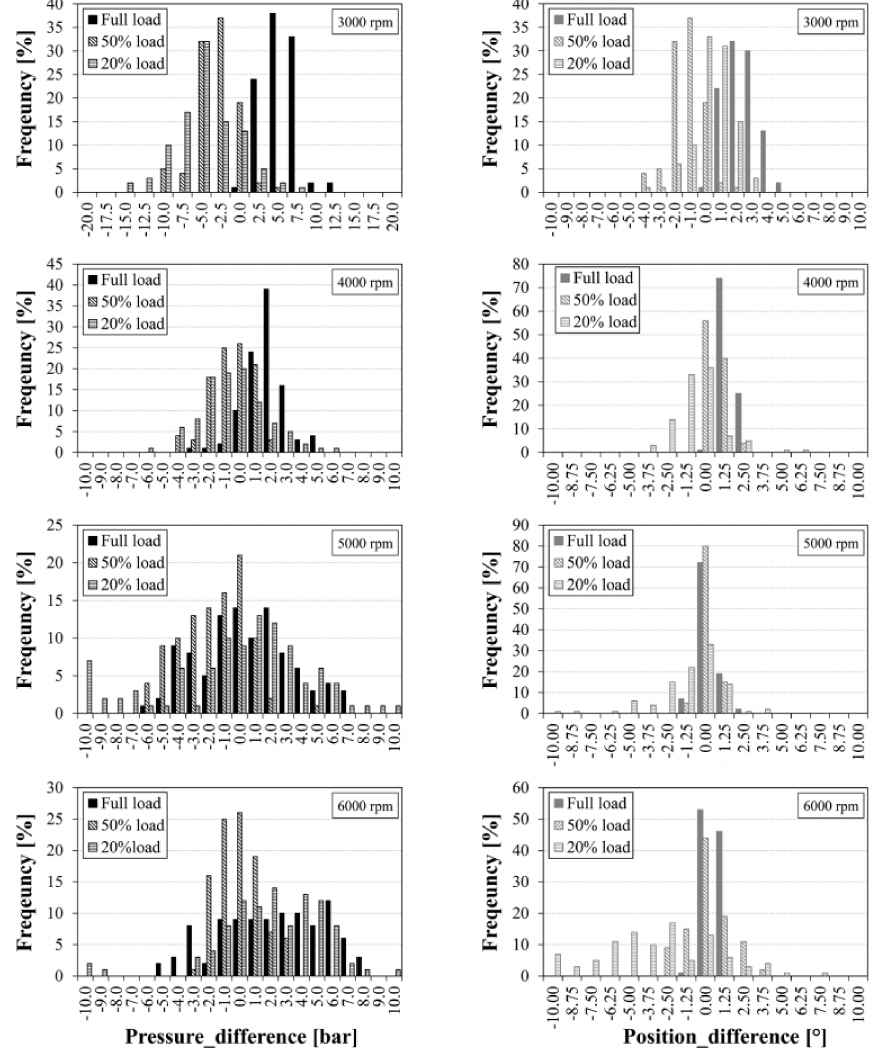
Figure 13. Error on the evaluation of the maximum in-cylinder pressure ( left ) and its angular position ( right ) considering 200 consecutive cycles for each graph. Engine speed from 3000 to 6000 rpm at 20%, 50% and 100% of the maximum